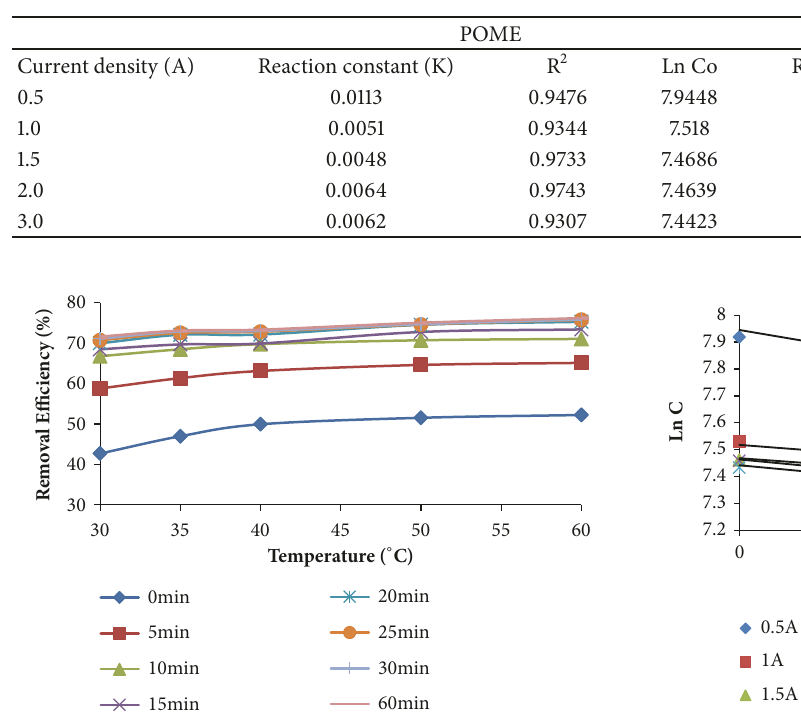
Table 3: First-order kinetics parameters for POME and PW.